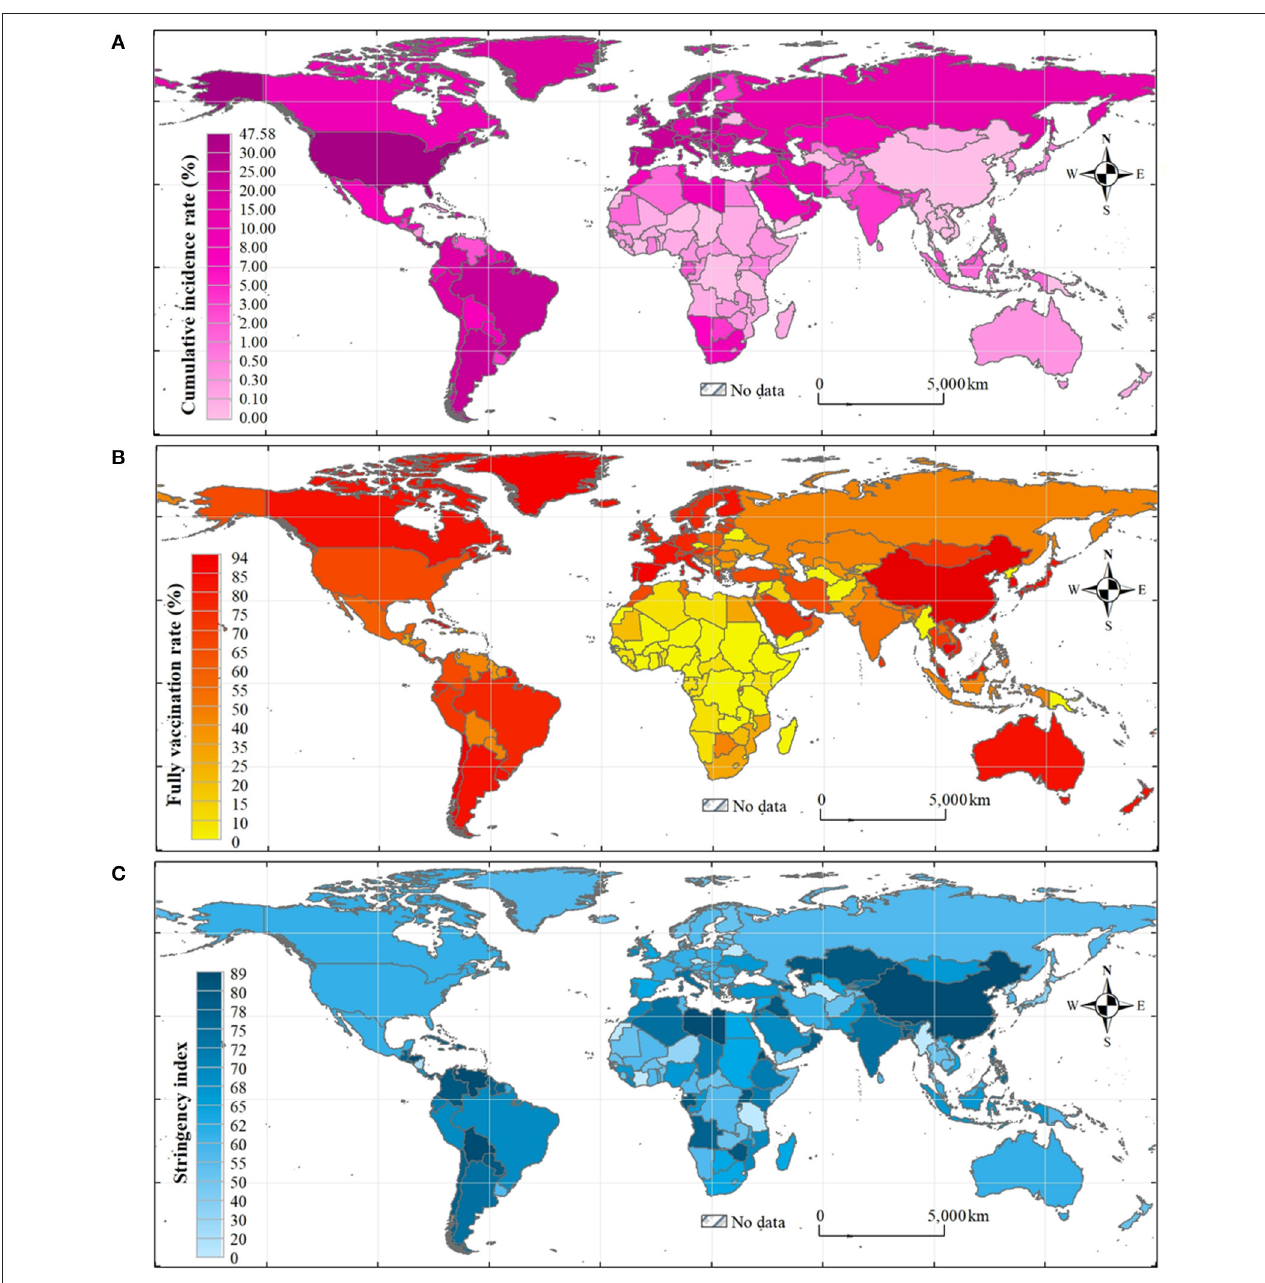
FIGURE 1 | Global distributions of cumulative incidence rate (A) , fully vaccination rate (B) , and stringency index (C) .